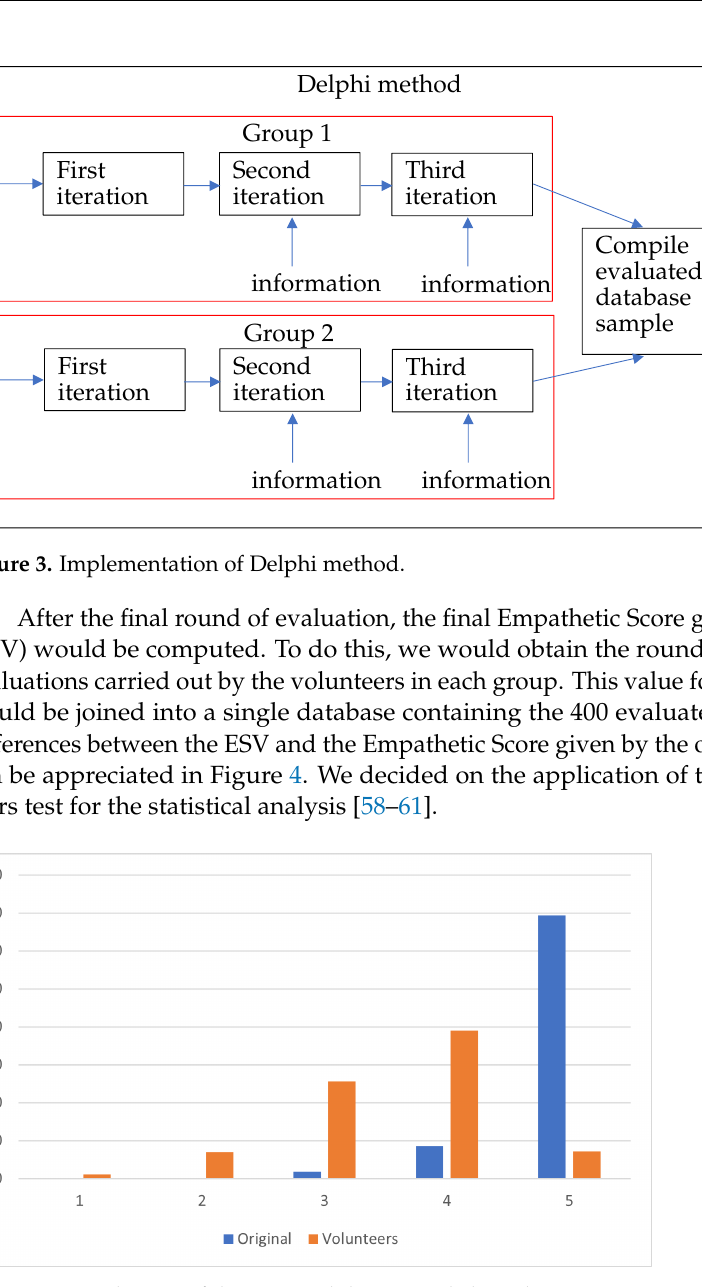
70 Table 1. EQ results for Groups 1 and 2. points, in accordance to Rashkin et al [38]. The Likert scale which was presented to the